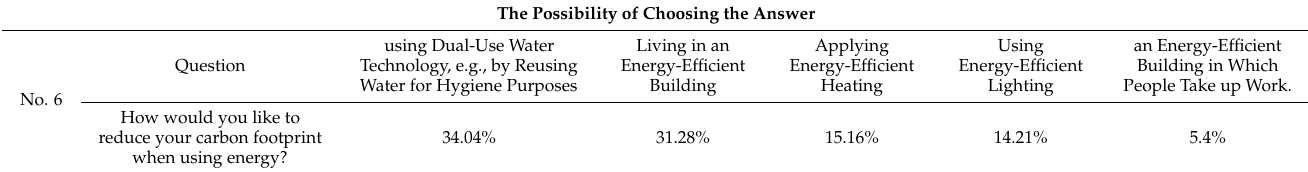
Table 6. Question no. 6, research results.